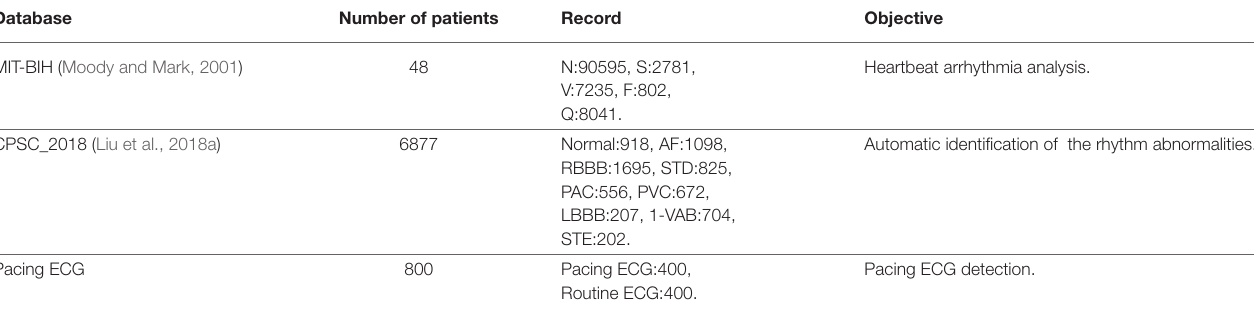
TABLE 1 | The specific data distribution in each database. Database